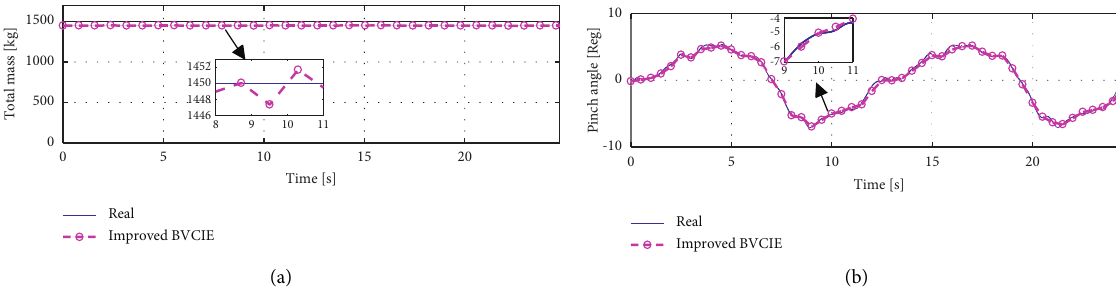
Figure 8: Estimation results by the improved BVCIE at 40 km/h on asphalt road. (a) Estimated total mass. (b) Estimated pitch angle. -10010